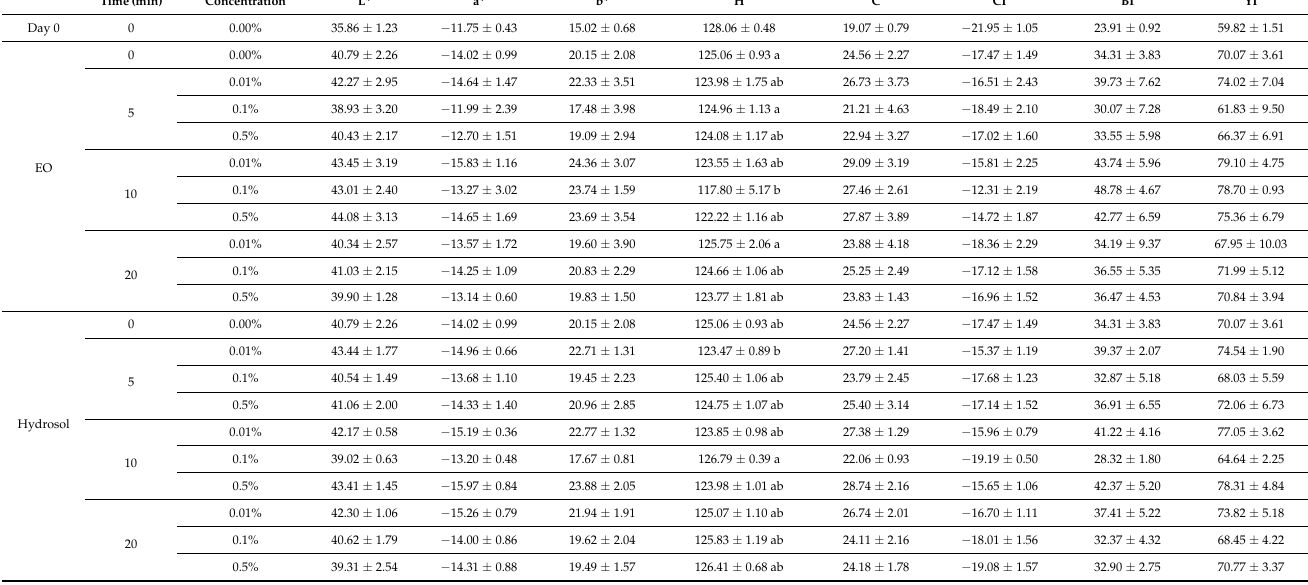
Table 4. Screening of O. dubium EO and hydrosol application effects on fresh cucumber color parameters (L*, a*, b*, hue (h), chroma value (C), color index (CI), browning index (BI) and yellowing index (YI)) when stored at 11 ◦ C for 9 days. Values presented as mean ± standard error of four biological replicates per treatment. Measurements for day 0 refer to the control. In each column and for each treatment (EO and hydrosol), significant differences ( p < 0.05) are indicated with different Latin